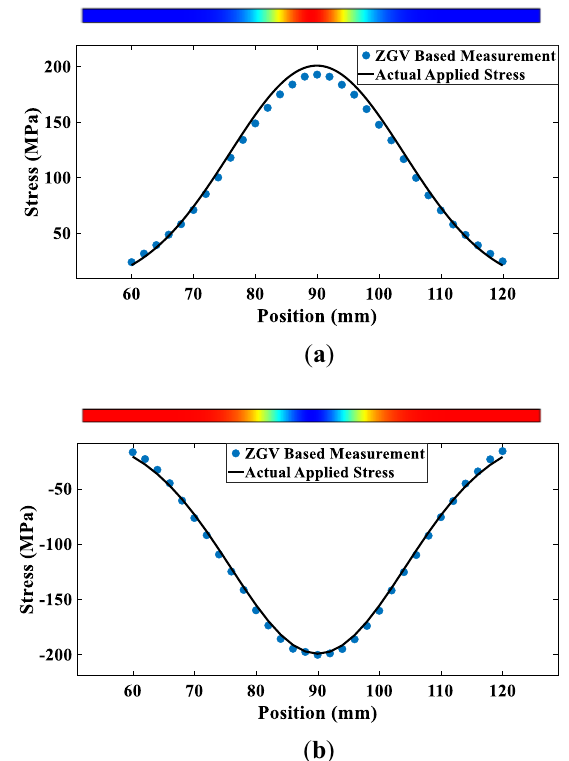
Figure 11 Measurement for localized stress field: ( a ) S1-ZGV based results for tensile stress field, and ( b ) S1-ZGV based results for compressive stress